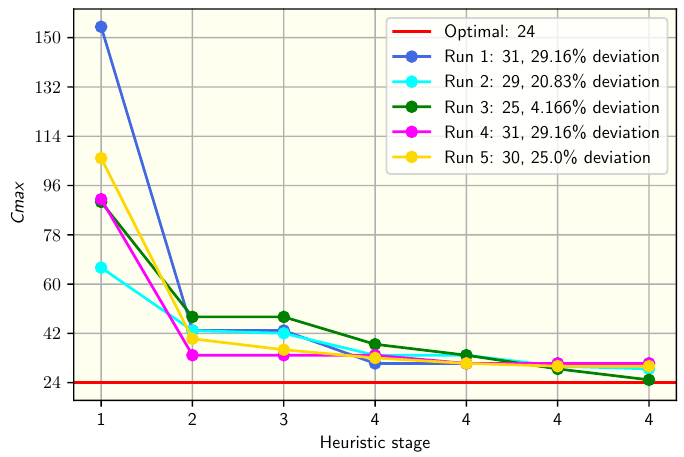
Figure 3. Five runs and its results for a medium instance in alternative two.